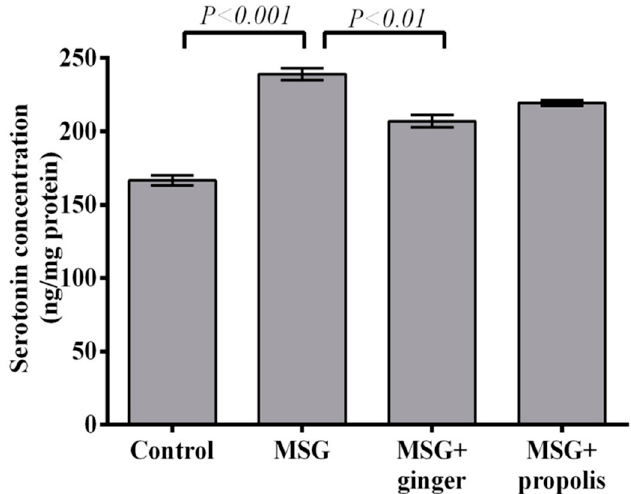
Figure 14. Cerebral cortex serotonin concentration at two months post-treatment. Data are expressed as mean ± SEM ( n = 6). Comparisons were made between normal control and MSG control groups, and between MSG control and MSG plus ginger or propolis supplement groups as well. Table 2. Effect of ginger and propolis on calcium, sodium and potassium levels of brain tissues in MSG-treated rats.